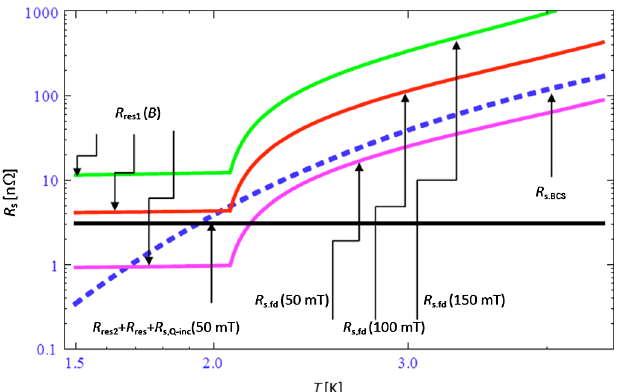
FIG. 8. Contributions to the surface resistance at 704 MHz shown separately (green: R s;fd at 150 mT; red: R s;fd at 100 mT; magenta: R s;fd at 50 mT; dashed blue: R s; BCS ; black: sum of residual resistances R res and R res 2